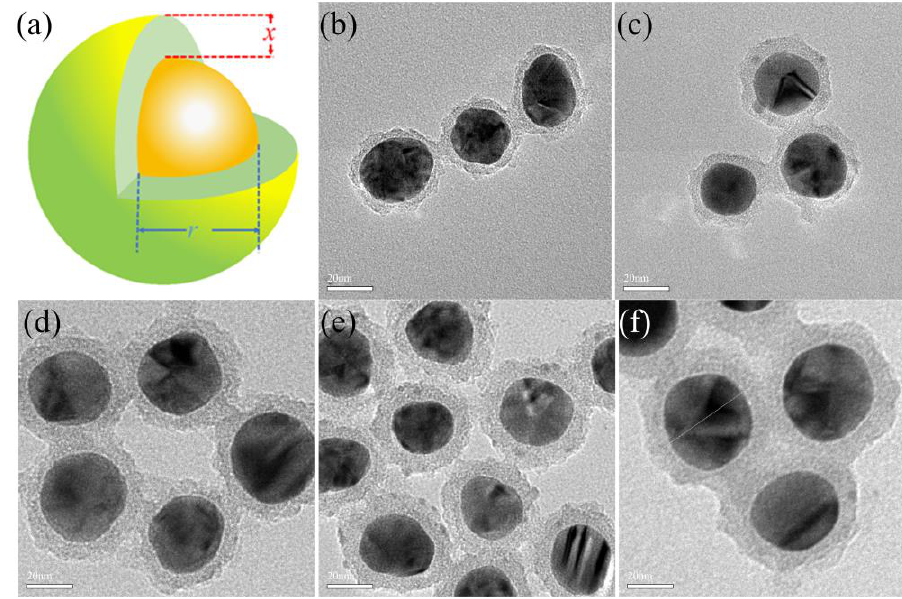
Figure 1. ( a ) Schematic diagram of Ag@SiO 2 core-shell nanoparticle structure. TEM images of Ag@SiO 2 core-shell nanoparticles with different shell thickness: ( b ) 3 nm, ( c ) 5 nm, ( d ) 7 nm, ( e ) 9 nm,